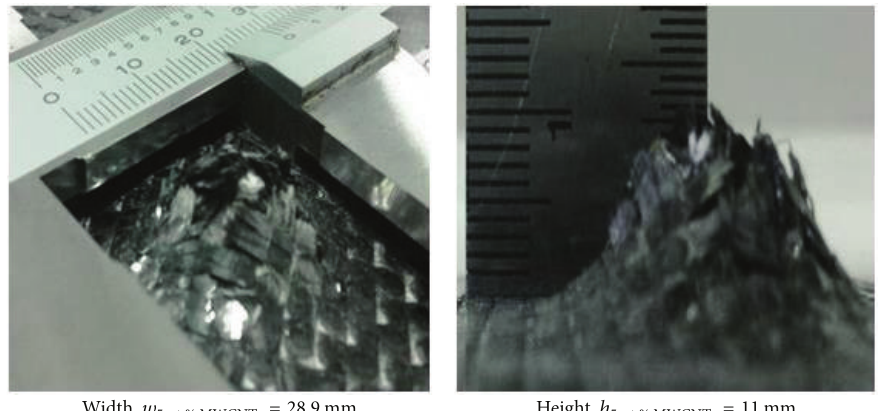
Width, w 5wt.%MWCNTs = 28.9 mm Figure 9: Pyramidal damage of asymmetric CFRP with 5 wt.% MWCNTs mixed in